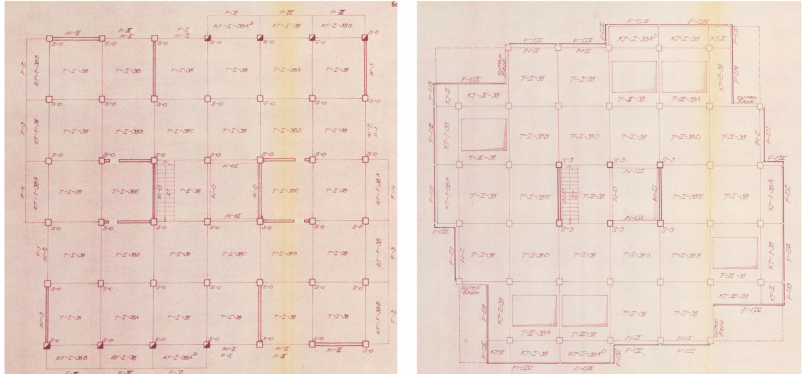
Figure 14. IMS Building B + 14 in Block No. 70: Different floors open plan (source: original drawing sheet from Historical Archives of New Belgrade,